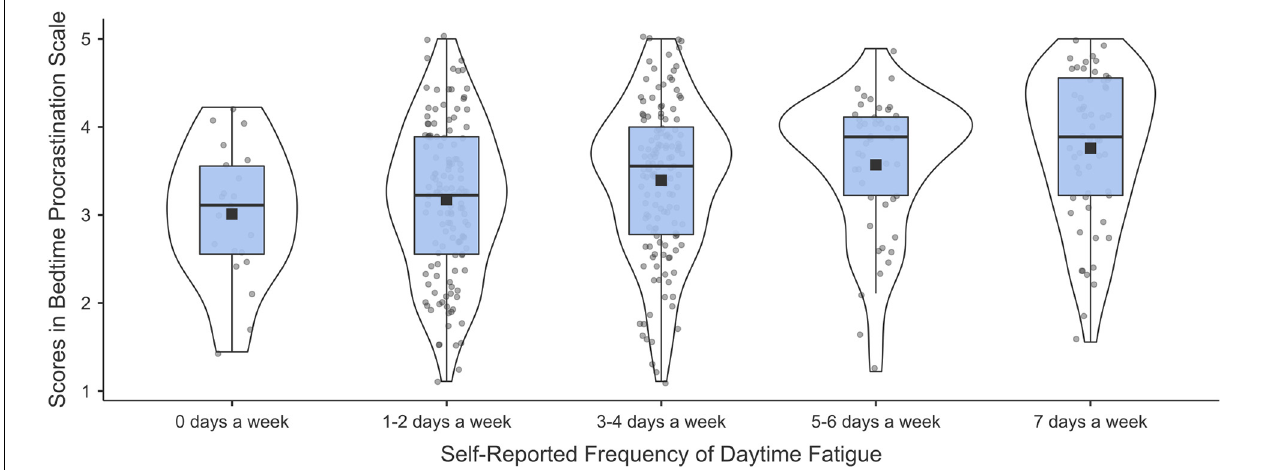
FIGURE 2 | Violin plot showing the distribution of scores in the Bedtime Procrastination Scale at the different values of self-reported frequency of daytime fatigue. square points – means; bold horizontal lines – medians; box edges – lower and upper quartiles; the lower ends of the whiskers – minimal value or 1.5 interquartile range below lower quartile; the upper ends of the whiskers – maximal values; the violin lines – the probability densities of the scores in Bedtime Procrastination Scale, smoothed by a kernel density estimator; dots – jittered data points.